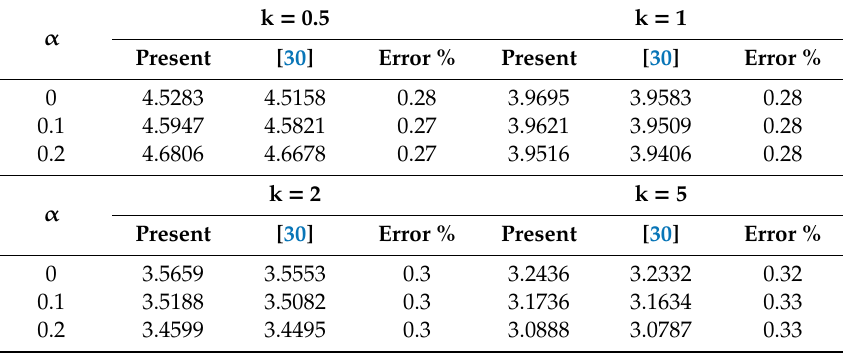
Table 4. Dimensionless natural frequencies of a simply supported, functionally graded square cross-sectional beam with